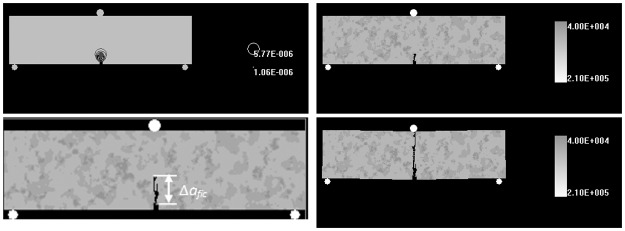
Failure process of 3-p-b test (notch length = 1mm) of granite disc with numerical simulation.(a) 200th load step (b) 348th load step (c) 380th load step (d) 500th load step.